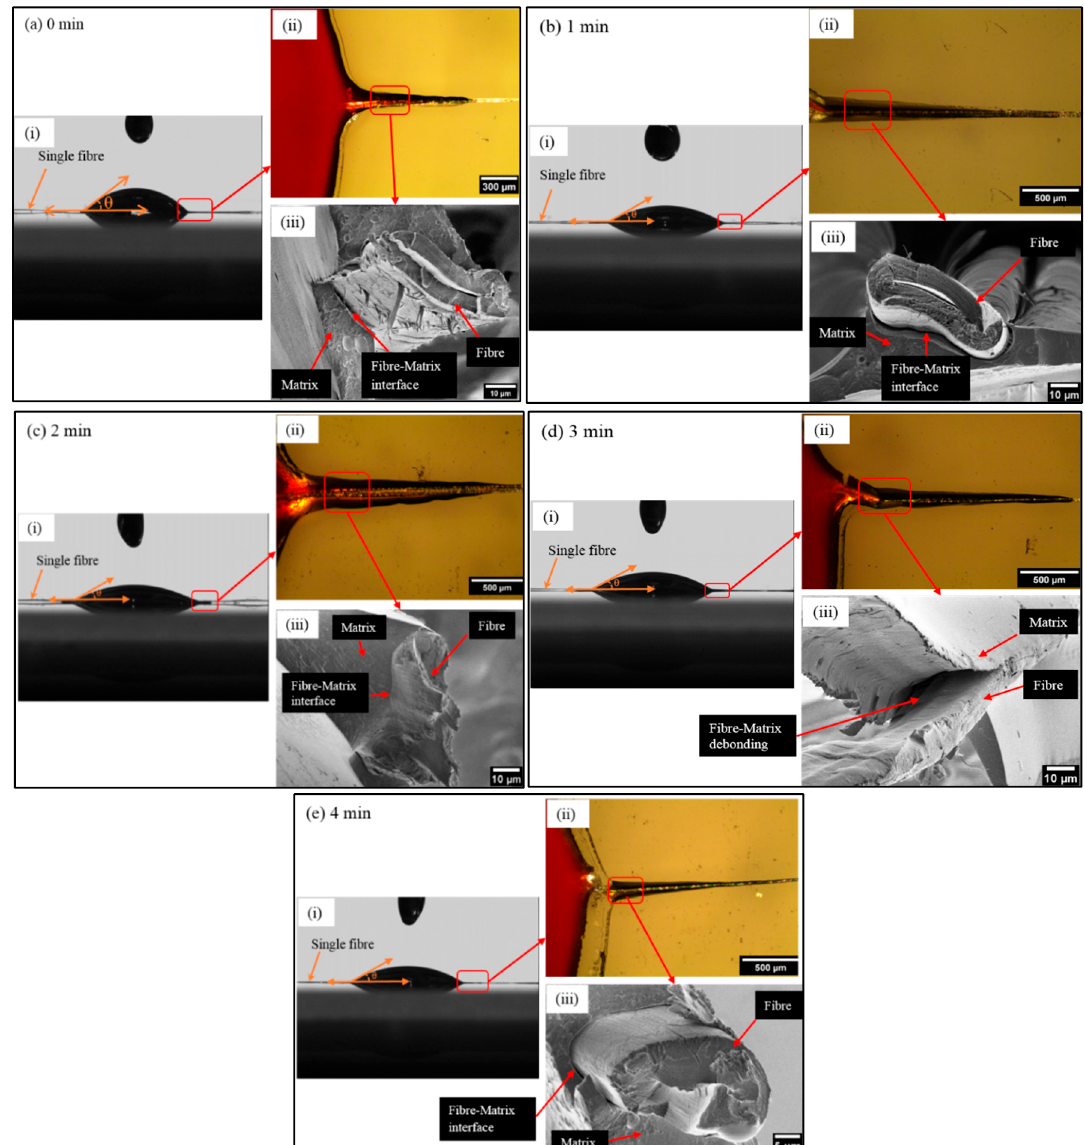
Figure 8. Phenolic resin drops on single ramie fibers plasma treated at various times: ( a ) 0 min, ( b ) 1 min, ( c ) 2 min, ( d ) 3 min, and ( e ) 4 min. Subfigures display: (i) measured angle of single ramie fiber with phenolic resin, (ii) optical microscopy image of single ramie fiber wetted by phenolic resin after curing, and (iii) LV-SEM image of single ramie fiber/phenolic resin interface.